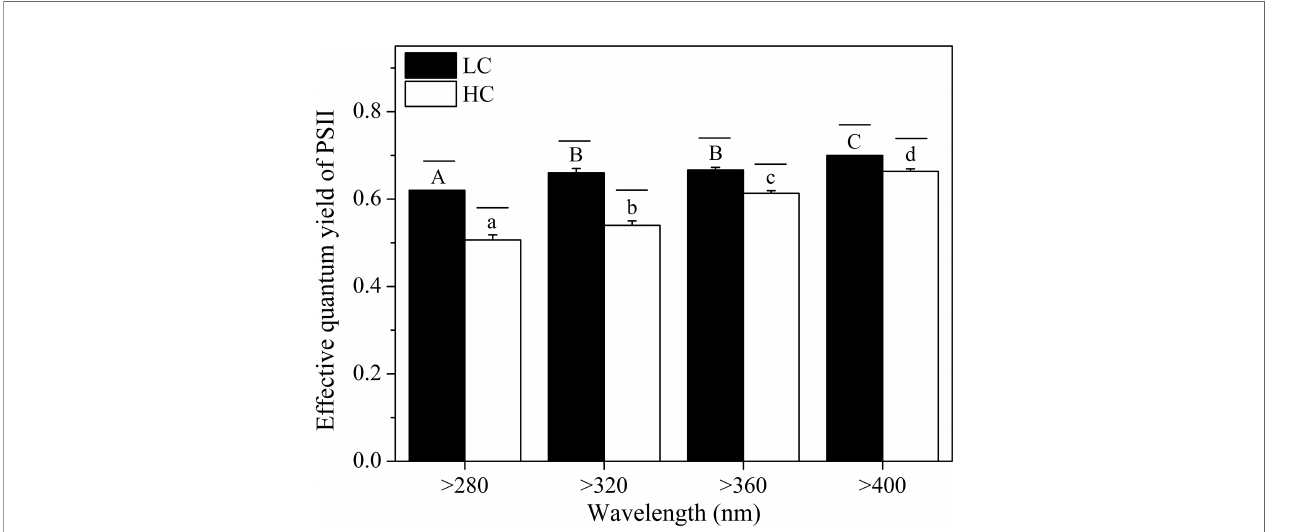
FIGURE 6 | The effective quantum yield of PSII (Fv ’ /Fm ’ ) of S. costatum acclimated to ambient (LC, black bars) and elevated CO 2 (HC, white bars) in different spectral treatments. The different uppercase and lowercase letters represent signi fi cant differences between different spectral treatments under LC and HC conditions, respectively.